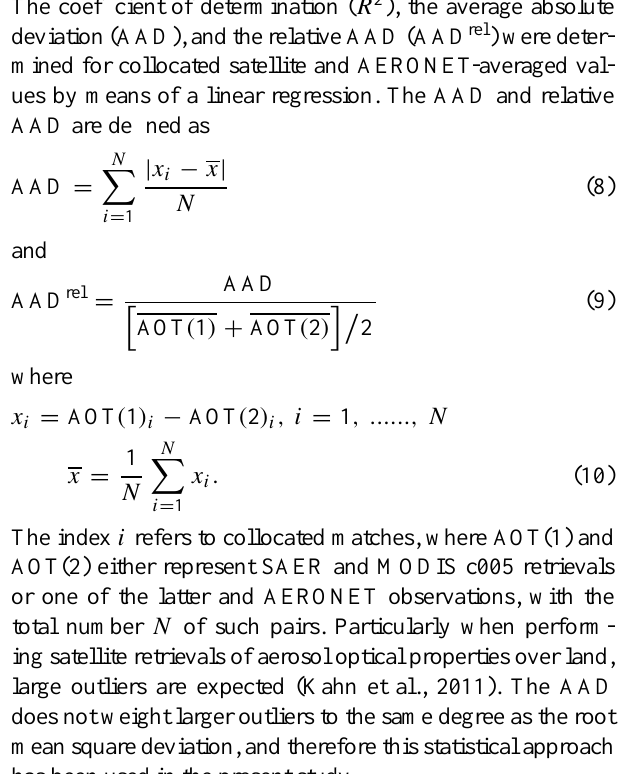
and automatically cloud screened (Smirnov et al.,